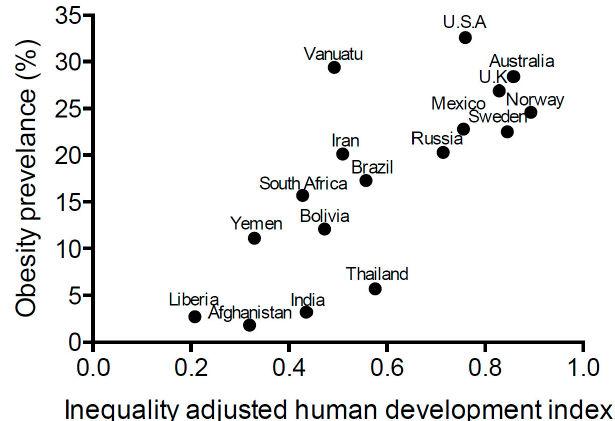
Figure 1. Obesity prevalence. The prevalence of obesity in a selection of countries with varying degrees of development according to the inequality adjusted human development index, which takes into account life expectancy and quality, years and quality of education and the income of the average citizen [4], was calculated using data from the United Nations Development Programme (2015) [5]. Obesity prevalence is accurate as of the year 2014 from data collected by the World Health Organisation [6]. A significant positive linear relationship between human development index and obesity prevalence is observed ( p = 0.0003, r = 0.58; Pearson test).